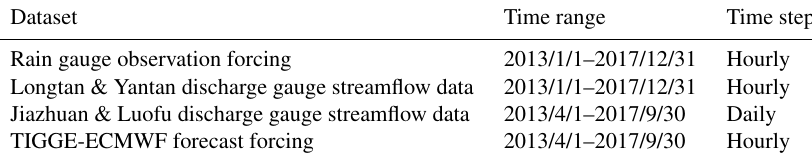
Table 2. Information on hydrological datasets. (Please note that dates are given in the following format in this table: yyyy/mm/dd.)